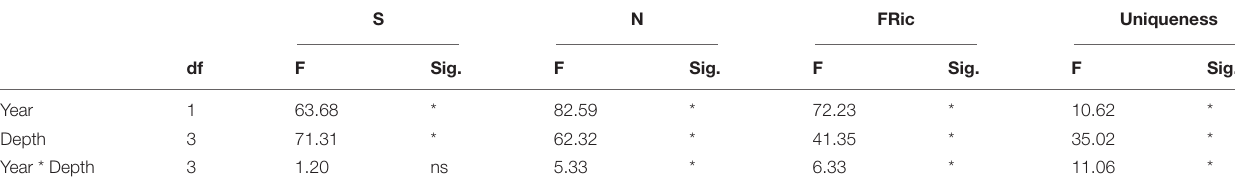
Significant differences at p < 0.05 indicated with “*” and non-significant indicated with “ns”.